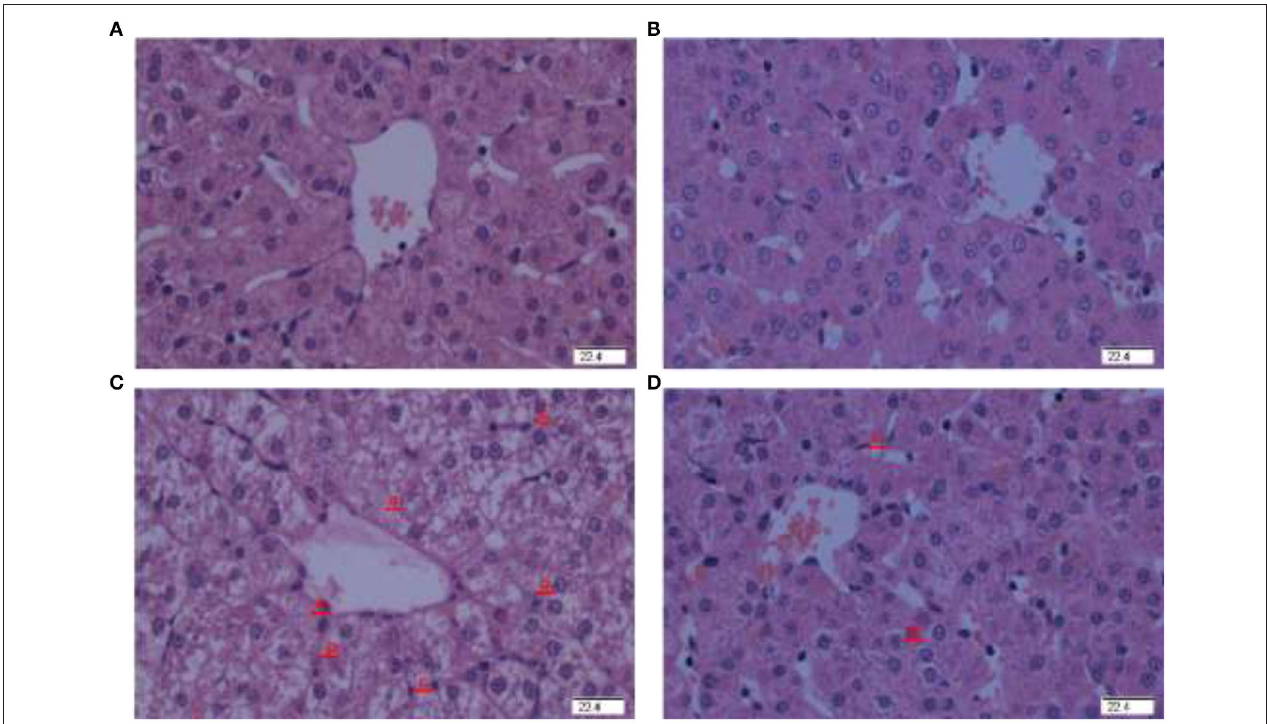
FIGURE 1 | Effect of holly polyphenols extracts (HPE) supplementation on hepatic morphology after 7 d diquat challenge in weanling piglets. Representative liver photomicrographs are shown. (A) Pigs fed a basal diet and treated with 0.9% NaCl solution. (B) Pigs fed a HPE diet and treated with 0.9% NaCl solution. No obvious pathological changes were observed. (C) Pigs fed the same basal diet and challenged with diquat. Significant pathological changes of liver damage such as hepatic spindle cells disappear (a), hepatocyte caryolysis (b), hepatocyte karyopycnosis (c), hepatic cell cords arrangement in disorder were found. (D) Pigs fed a HPE diet and challenged with diquat. Liver damage was significantly alleviated. n = 8 (1 pig/pen). Original magnifications 400 × . Scale bars = 22.4 µ